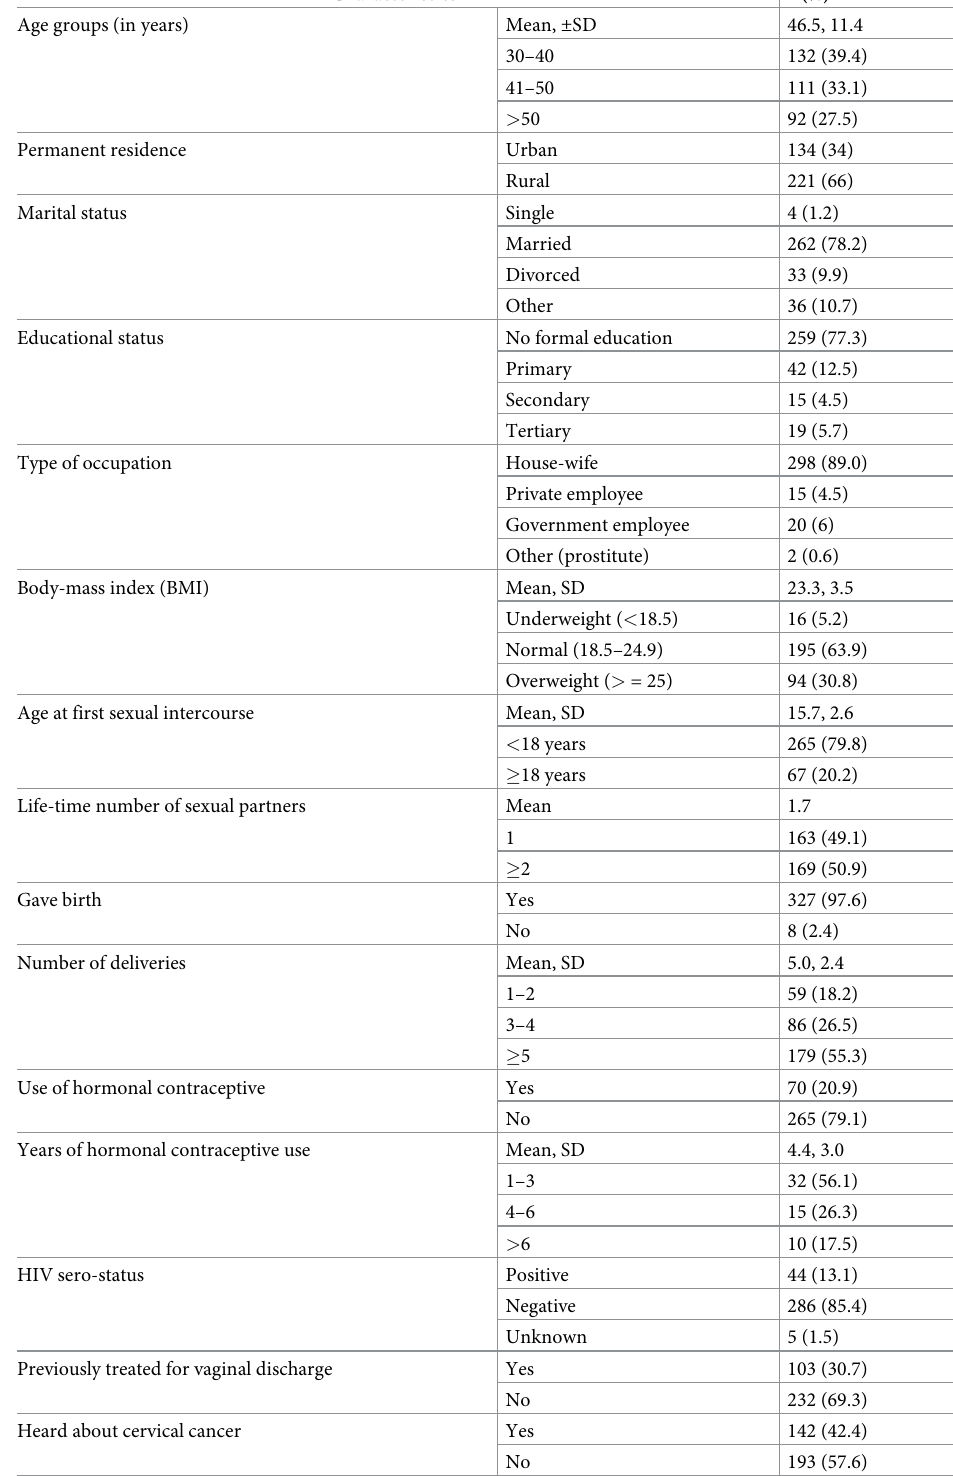
Table 1. Distribution of the study participants by their demographic and clinical